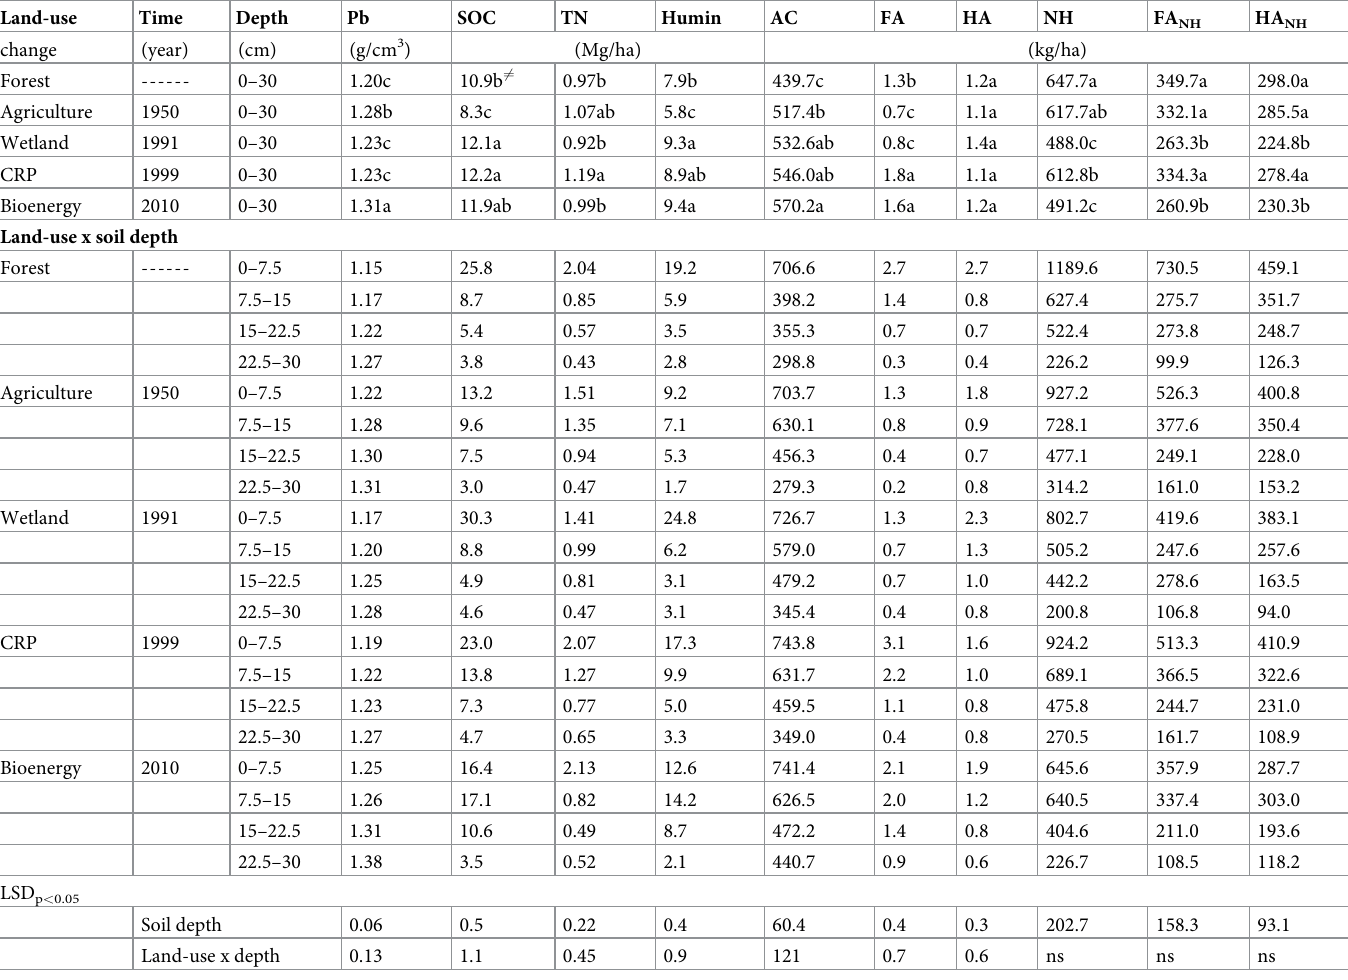
Table 3. Impact of deforestation and subsequent land-use diversity on blk density ( ρ b), total organic carbon (SOC), total nitrogen (TN), active carbon (AC), fulvic acid (FA), humic acid (HA), humin, and glucose equivalent total non-humic carbon (NH), fluvic acid associated glucose equivalent total non-humic carbon (FA NH ), and humic acid glucose equivalent total non-humic carbon (HA NH ) stocks at different soil